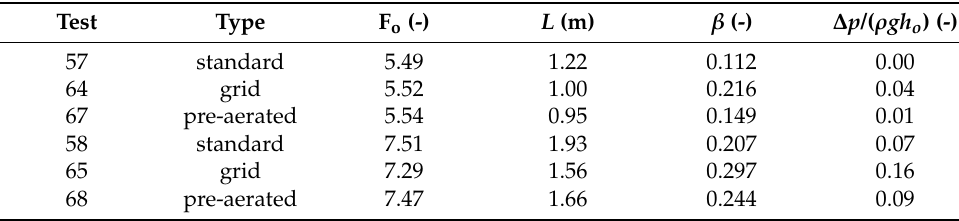
Table 2. Jet characteristics of standard, grid and pre-aerated aerator